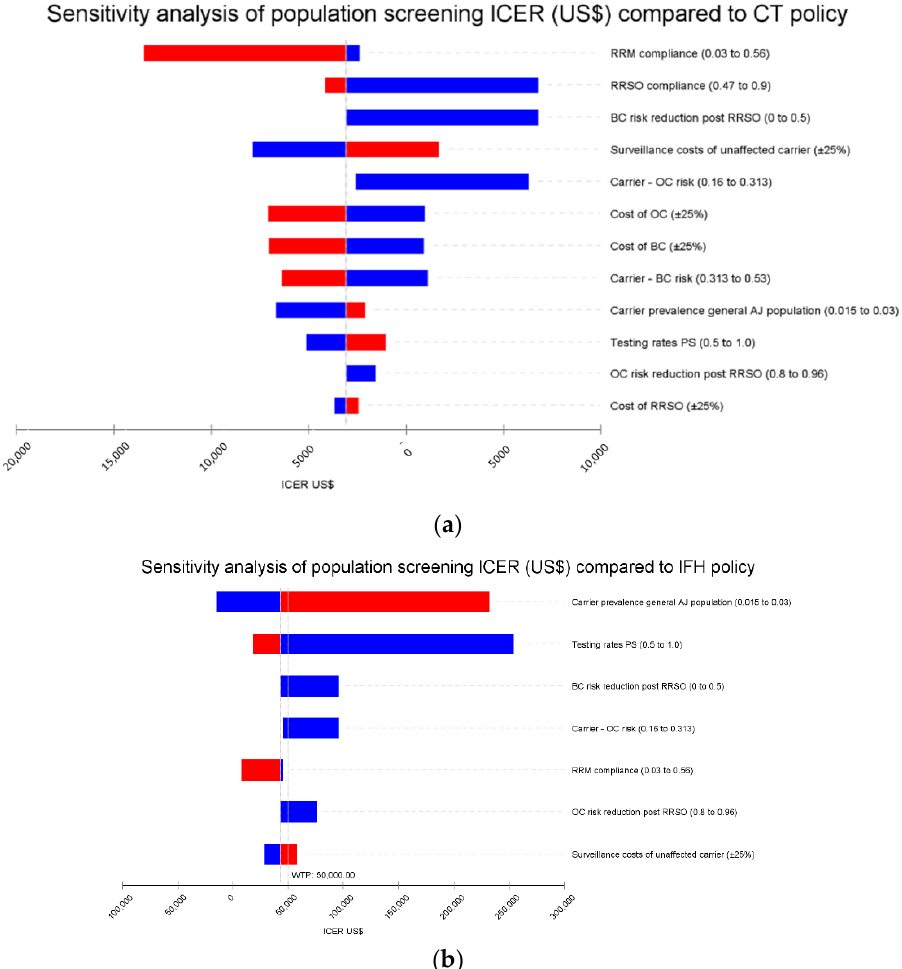
Figure 2. Sensitivity analysis comparing population screening to the other strategies. The results of the sensitivity analysis are shown as a tornado diagram. Variables and the range of values used in the sensitivity analysis are indicated to the right of the diagram. Red bars indicate the effect of increasing the variable (to the upper limit) on the ICER. Blue bars indicate the effect of decreasing the variable (to the lower limit) on the ICER. The vertical line (EV) indicates the ICER using the variable values in the original model. BC—Breast Cancer, OC—Ovarian Cancer, PS—Population screening, CT—Cascade testing, IFH–International Family-History based testing, RRM—risk-reduction mastectomy, RRSO—risk reduction salpingo-oophorectomy. ( a ) PS vs. CT, ( b ) PS vs. IFH.